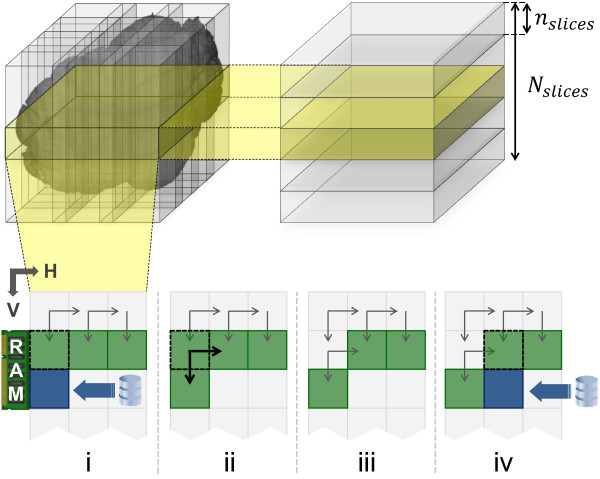
Memory management in the pairwise stacks displacements computation step. The whole volume is processed a layer at the time, each composed by nslicesslices. For each layer, stacks are read row-wise when there are more rows than columns (i-iv). A new substack is loaded (i) when its North substack needs it for displacement computation (ii). After that, the North substack can be released (iii) and this process is repeated for the next column (iv).